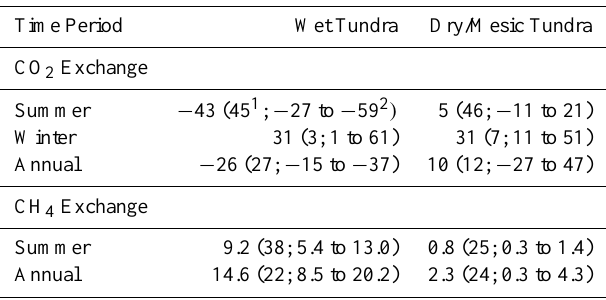
Table 4. Summary of observationally based estimates of mean net CO 2 -C and CH 4 -C exchange from Arctic tundra to the atmosphere (gCm − 2 season − 1 ) for different tundra